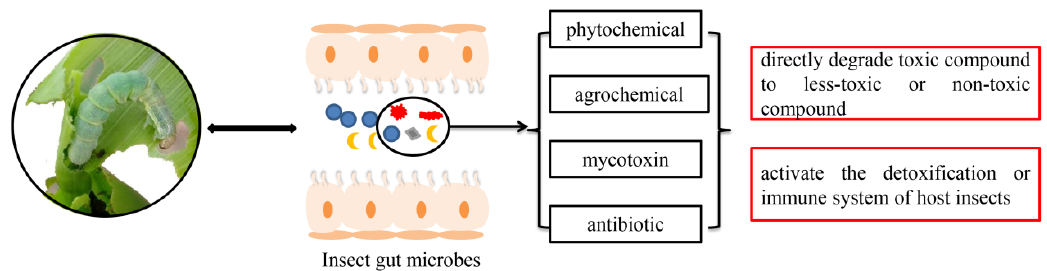
Figure 1. An overview of symbiont-mediated detoxification in